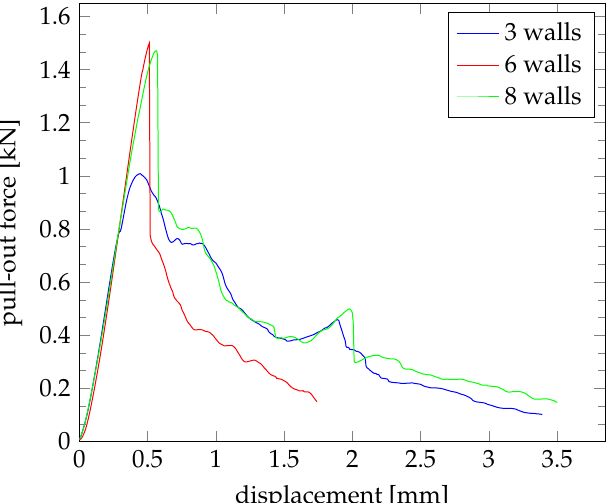
Figure 9. Characteristic force-displacement graphs of the pull-out tests for variations of the wall thickness.